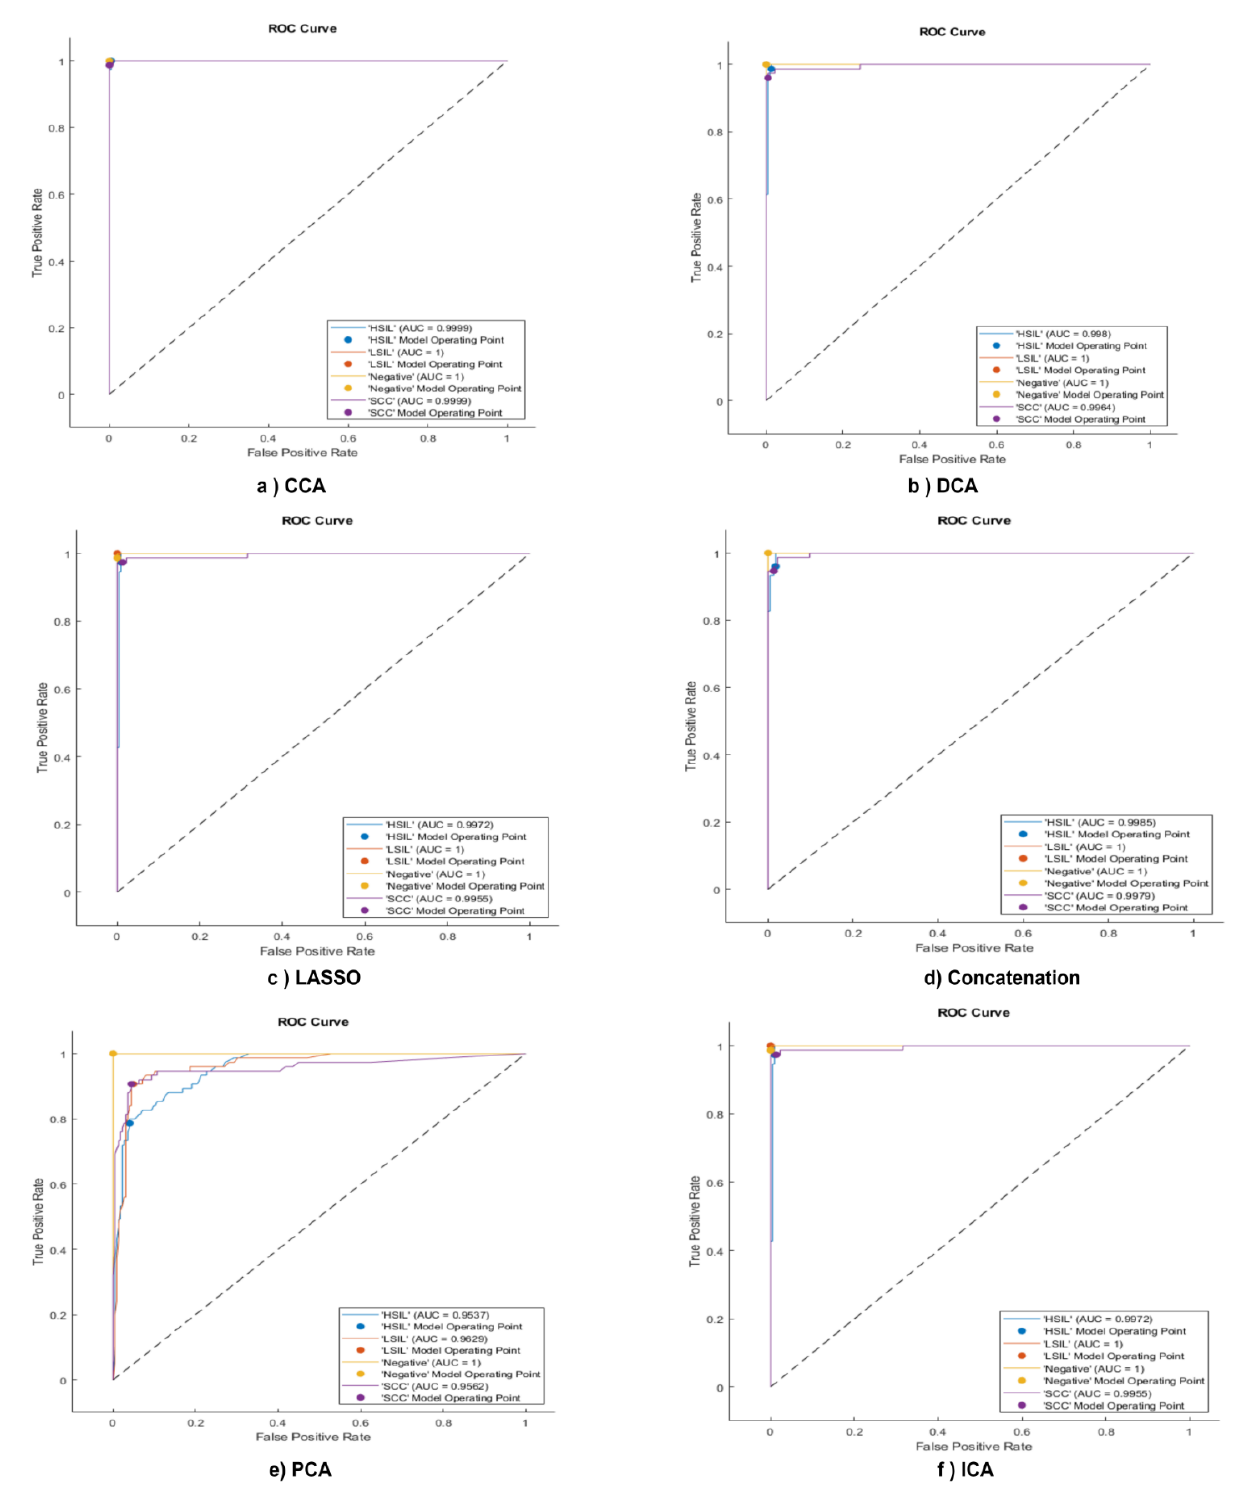
Figure 3. Six receiver operating characteristic curves of the SVM model when considering six feature fusion techniques. ( a ) Using CCA, ( b ) DCA, ( c ) LASSO, ( d ) concatenation, ( e ) PCA, and ( f ) ICA. The